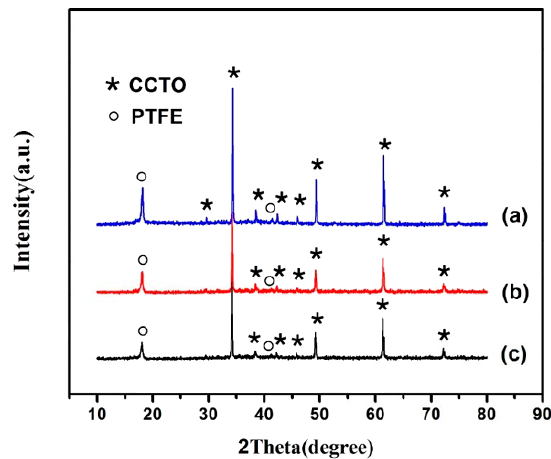
Figure 6. XRD patterns of the PTFE-based composite filled by different CCTO particle sizes: ( a ) micron CCTO filling; ( b ) submicron CCTO filling; and ( c ) micron/submicron-blended CCTO filling.